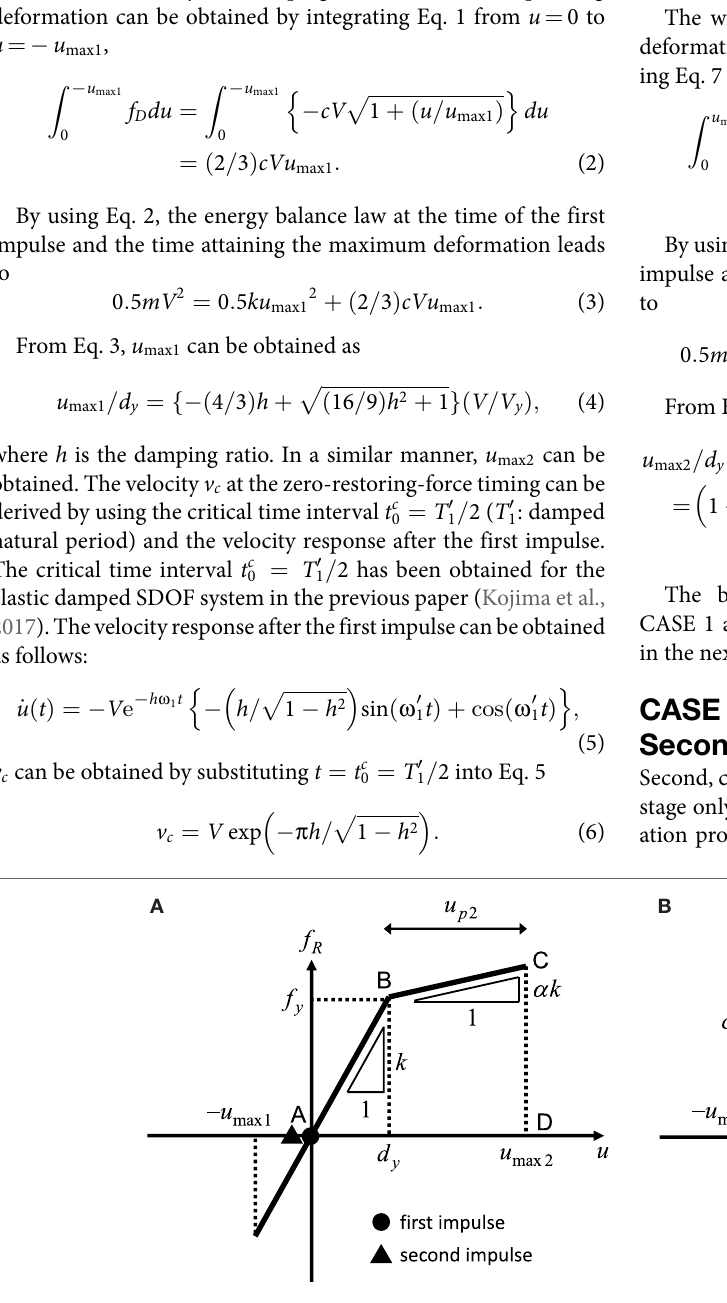
FIGURE 5 | Restoring force and damping force with respect to deformation in CASE 2 [( V / V y ) CASE1 (cid:20) V / V y (cid:20) ( V / V y ) CASE2 ], (A) restoring force–deformation relation, (B) quadratic approximation of damping force–deformation relation.